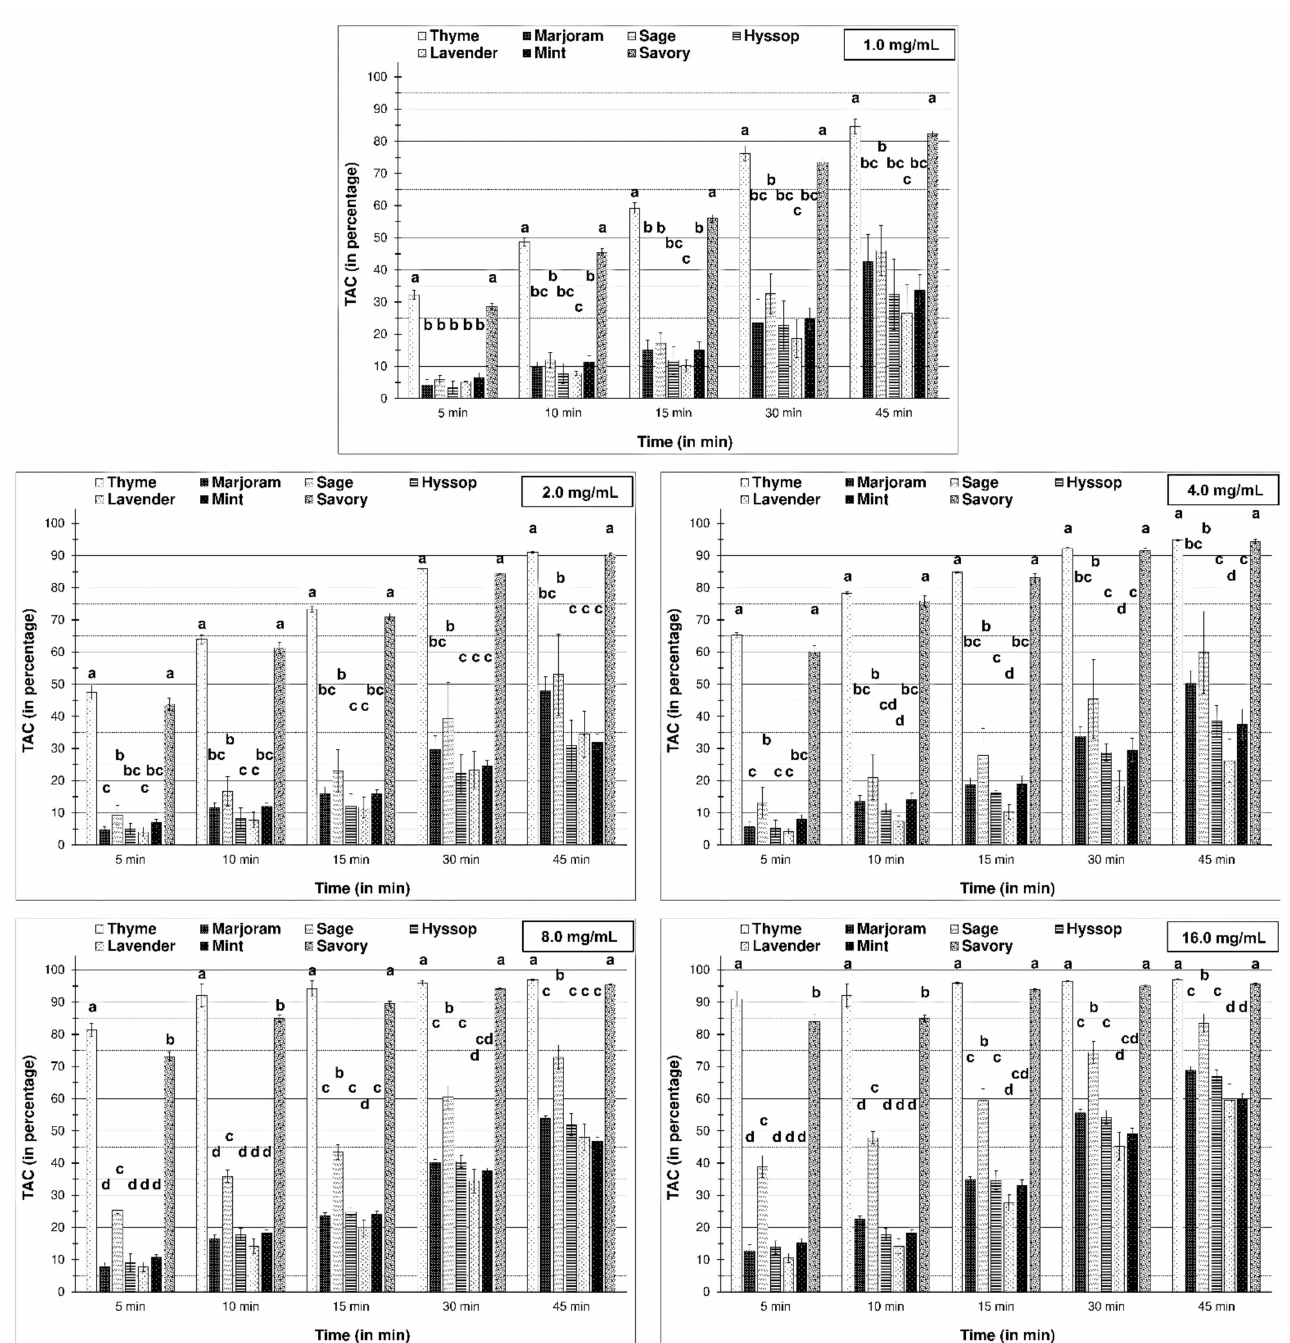
Figure 2. Total antioxidant capacity (as percentage of scavenging) of examined essential oils against DPPH radical; 1.0, 2.0, 4.0, 8.0, 16.0 mg/mL are concentration of essential oils in the reaction mixtures. The bars for each time period marked by different letters are statistically different at p < 0.05 (Tukey’s